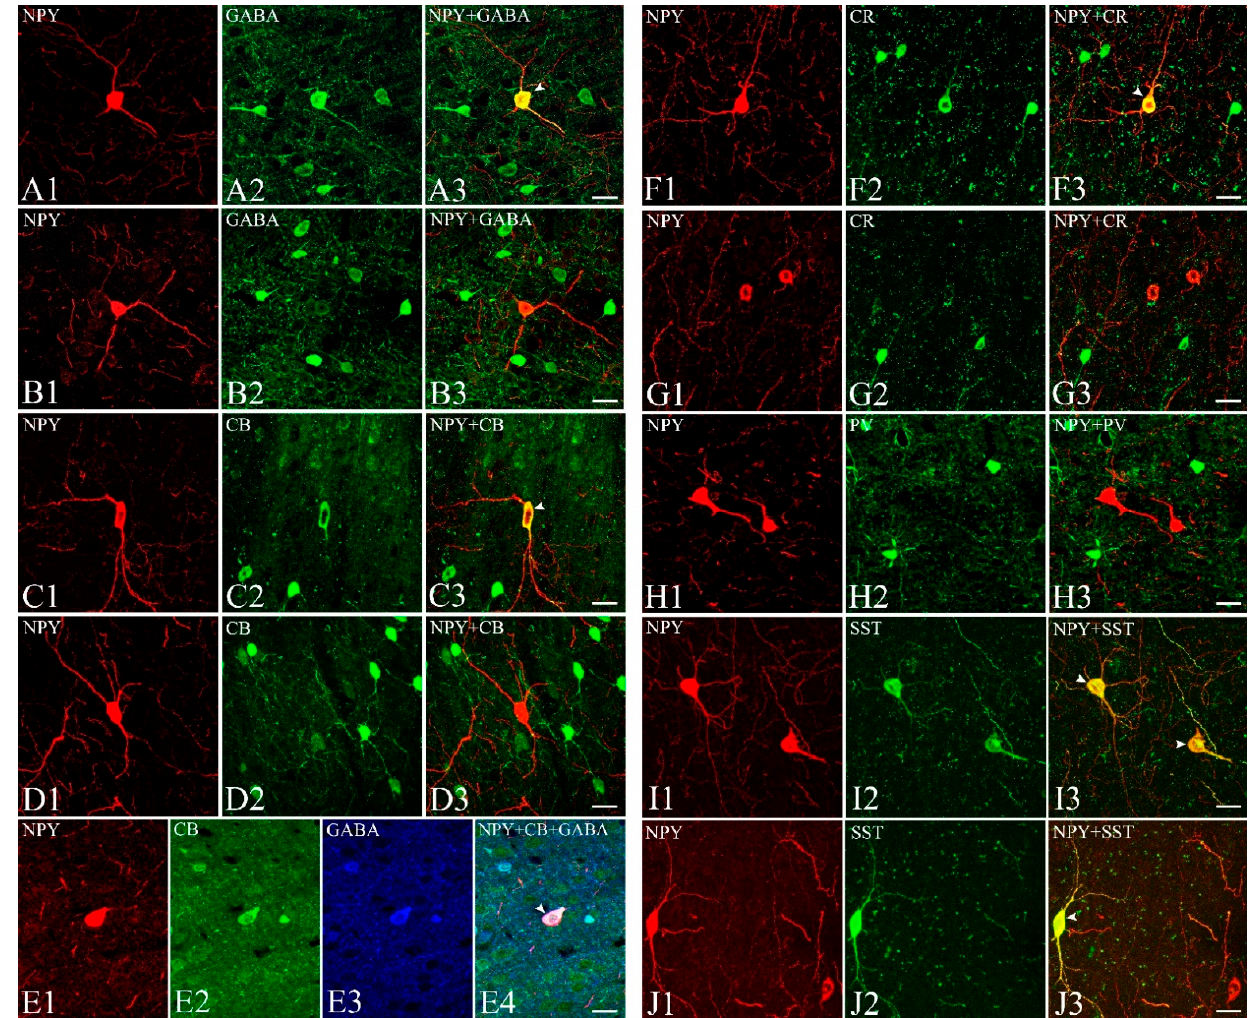
Figure 3. Colocalization of NPY with GABA-, CBPs-, or somatostatin-IR neurons in the gerbil visual cortex. Fluorescence confocal photomicrographs of the gerbil visual cortex immunostained for NPY ( A1 , B1 , C1 , D1 , E1 , F1 , G1 , H1 , I1 , J1 ), GABA ( A2 , B2 , E3 ), calbindin-D28K ( C2 , D2 , E2 ), calretinin ( F2 , G2 ), parvalbumin ( H2 ), and somatostatin ( I2 , J2 ). Superimposed images of NPY with GABA ( A3 , B3 ), CBPs ( C3 , D3 , F3 , G3 , H3 ), or somatostatin ( I3 , J3 ). Some of NPY-IR neurons were double- labeled with GABA (arrowhead in A3 ), calbindin-D28K (arrowhead in C3 ), calretinin (arrowhead in F3 ), and somatostatin (arrowheads in I3 , J3 ). NPY-IR neurons did not colocalize with parvalbumin-IR neurons ( H3 ). NPY-IR neurons double- labeled with calbindin-D28K were also labeled with GABA ( E4 ). CB, calbindin-D28K; CR, calretinin; PV, parvalbumin; SST, somatostatin. Scale bar = 20 µ